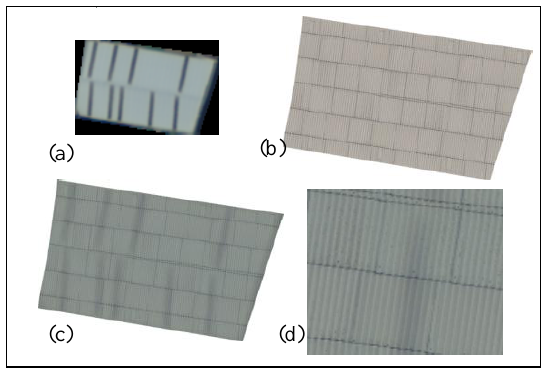
Figure 3. Original texture (a), raw synthesized texture (b) and mixed images with transparency (large and detailed views c, d).